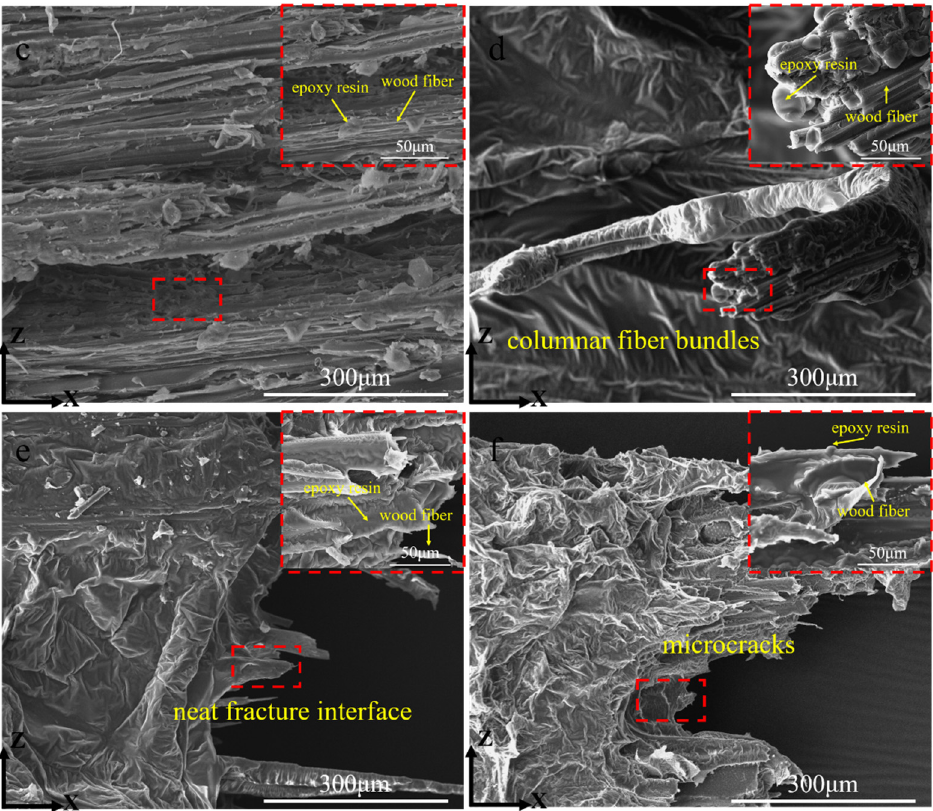
Figure 6. Variation of density and destruction forms of the interface of all specimens for ( a ) the variation of density; ( b ) stress − strain curves; ( c – f ) the destruction forms of the interface of TDPV, TADPV-1, TADPV-3, and TADPV-5, respectively. Table 1. Comparison of the mechanical properties of all of the specimens and other plastic sub- strates.